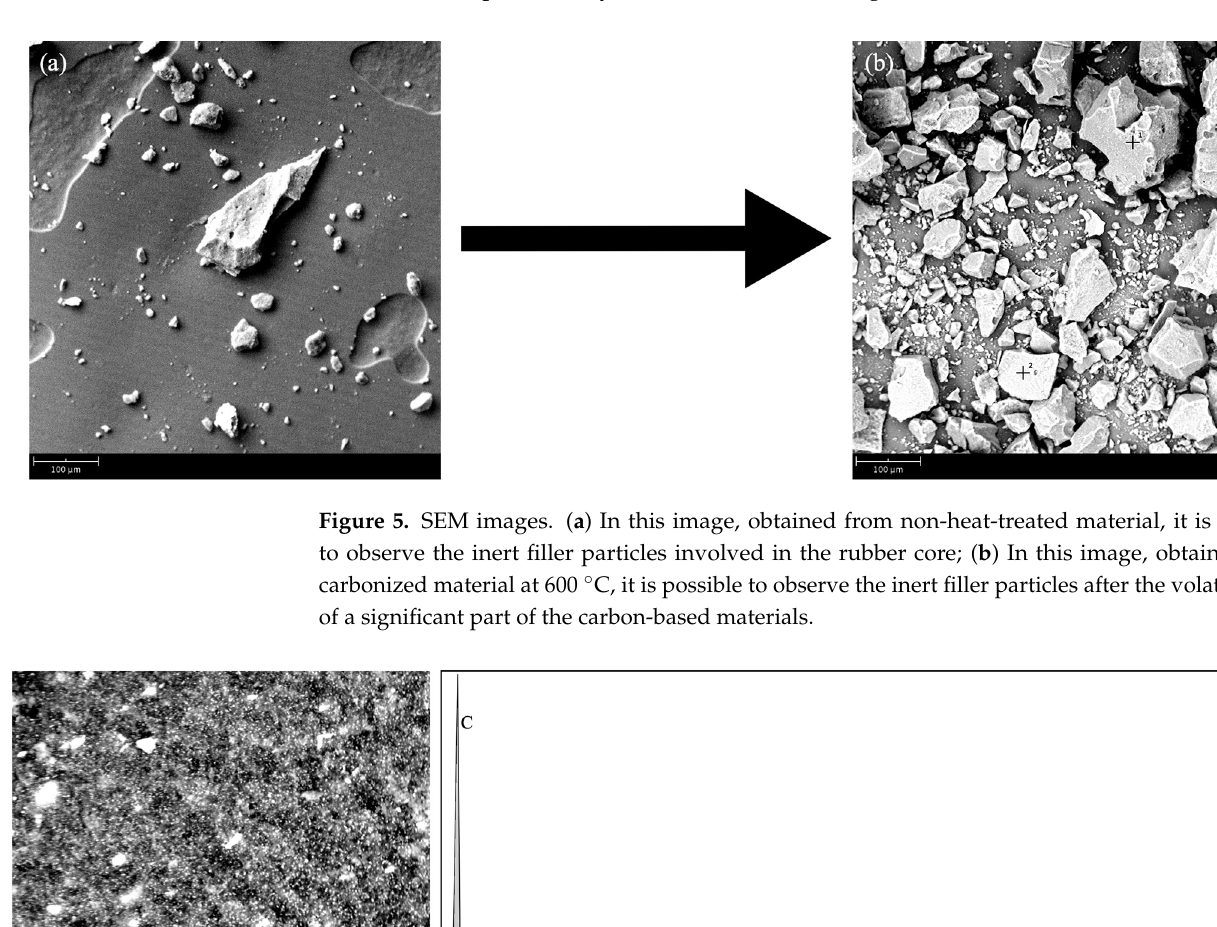
Figure 5. SEM images. ( a ) In this image, obtained from non-heat-treated material, it is possible to observe the inert filler particles involved in the rubber core; ( b ) In this image, obtained from carbon- ized material at 600 °C, it is possible to observe the inert filler particles after the volatilization of a significant part of the carbon-based materials.